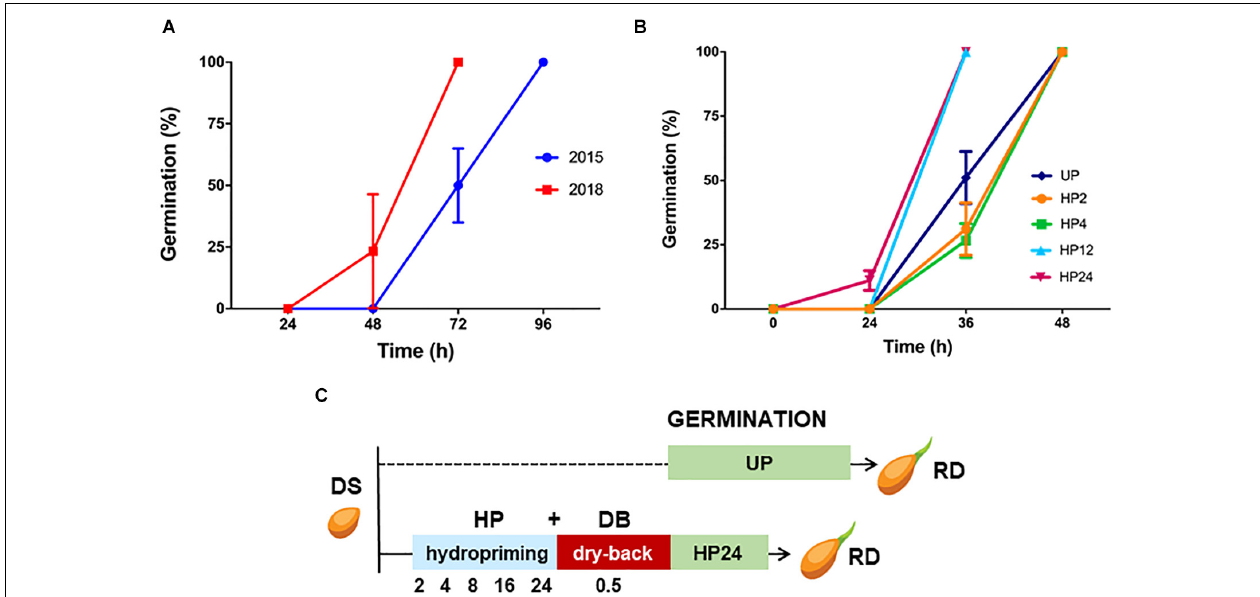
FIGURE 1 | (A) Germination curve of the S. villosum seed lots collected in 2015 and 2018. Values are expressed as mean ± SD of three independent replicates with 15 seeds for each replicate. Statistical analysis was carried out using Two-way ANOVA (see Table 1B ). (B) Results from germination tests carried out with S. villosum seeds (collected in 2015) and treated with hydropriming for 2, 4, 12, and 24 h and with unprimed (UP) seeds. Values are expressed as mean ± SD of three independent replications with 15 seeds for each replication. Statistical analysis was carried out using Two-way ANOVA (see Table 2B ). (C) Experimental design for the study of the seed response to the hydropriming treatment HP24 in S. villosum . DS, dry seed. HP, hydropriming. DB, dry-back. UP, unprimed. RD, radicle protrusion. TABLE 1 | (A) Germination parameters calculated based on results of germination tests carried out on the S. villosum seed lots collected in 2015 and 2018, respectively. (B) Results of Two-way ANOVA analysis comparing germination parameters of the S. villosum seed lots collected in 2015 and 2018, respectively, carried out using the post hoc Tukey’s HSD test. Values are expressed as means ± SD from three independent replicates. Asterisks indicate statistically significant differences between the two seed lots determined using Student’s t test ( P < 0.05). G, germinability; MGT, mean germination time; CVG, coefficient of velocity of germination; MGR,